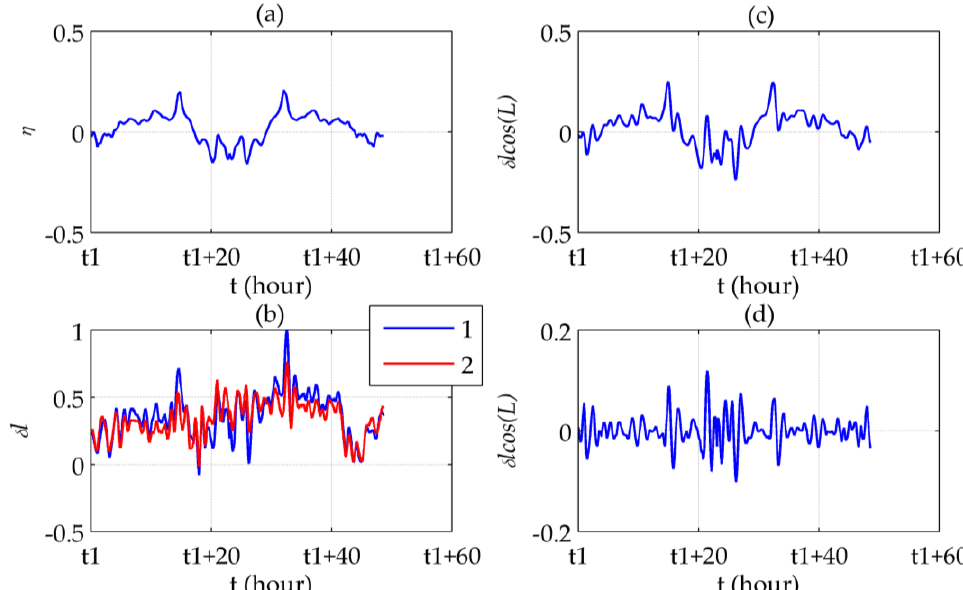
Figure 12 . Longitudinal results of the round-trip experiment: ( a ) η ; ( b ) Longitude errors before (line 1) and after (line 2) compensation; ( c ) Compensated longitude error; ( d ) Difference between η and the compensated longitude error.